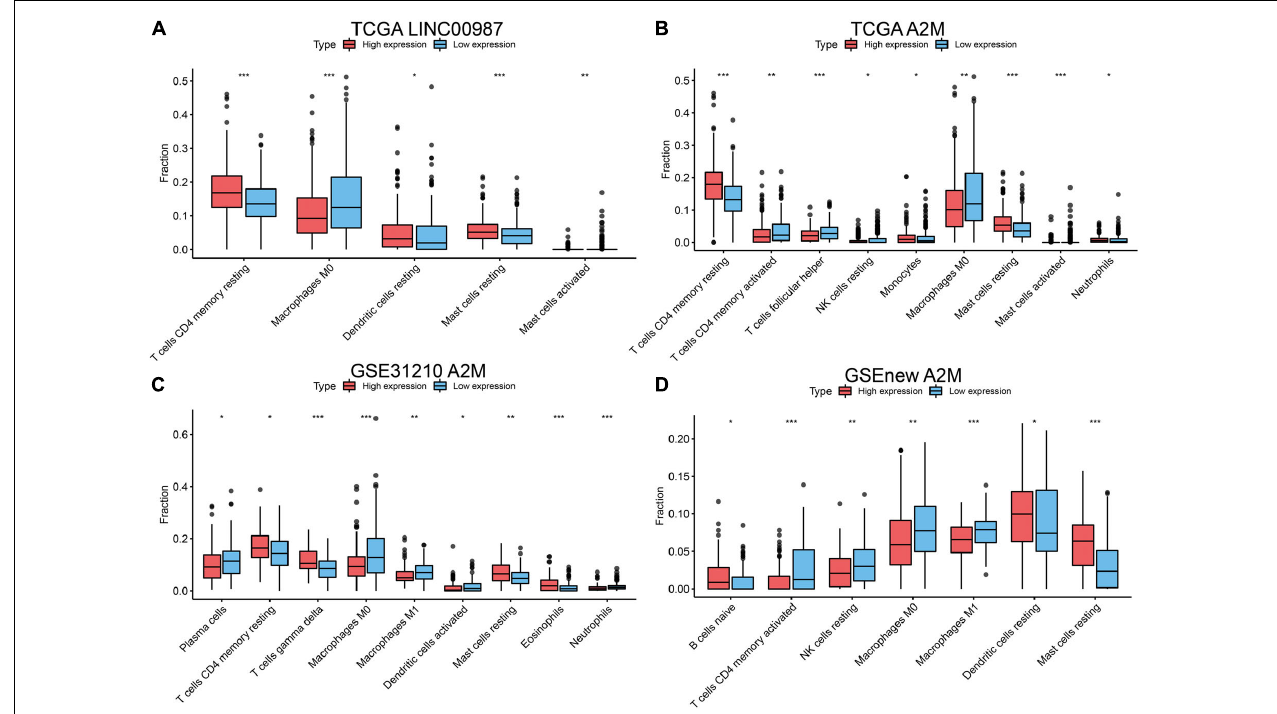
FIGURE 5 | Differences in the distribution of 22 human immune cells in LINC00987 and A2M expression groups estimated using the CIBERSORT algorithm. Boxplots for (A) LINC00987 and (B) A2M in the TCGA cohort. Boxplots for A2M in the (C) GSE31210 and (D) GSEnew cohorts. * p < 0.05, ** p < 0.01, and *** p <